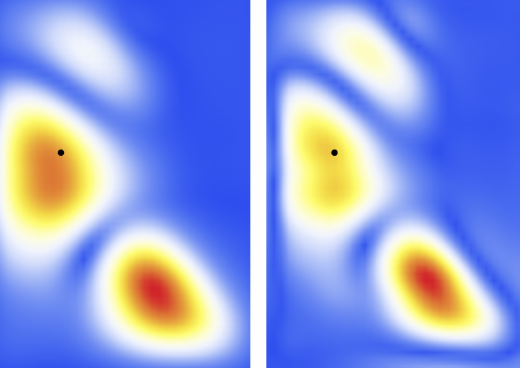
Figure 9. Sound field recorded 50 mm above a grand piano sound board ( left ) and back-propagated sound board vibration according to the MEM ( right ). The black dot marks the input location of the acoustic